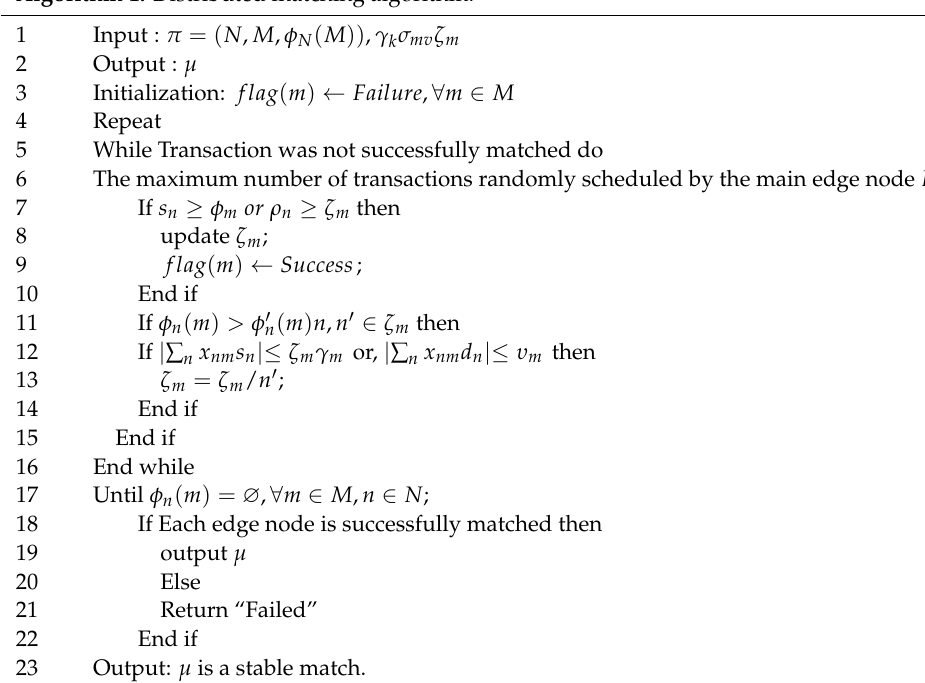
Algorithm 1: Distributed matching algorithm.